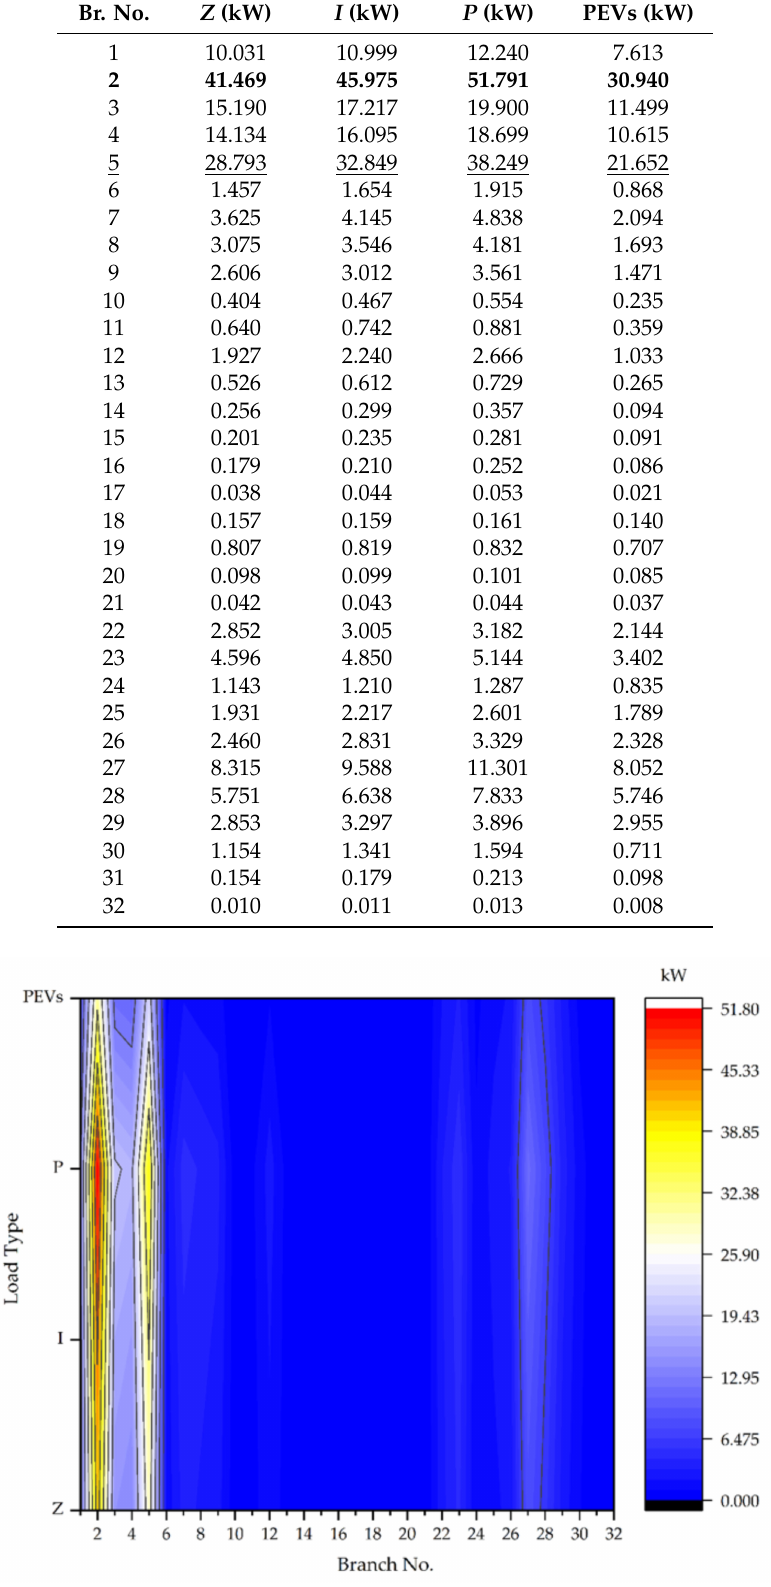
Figure 4. Contour of lines active power losses when difference load